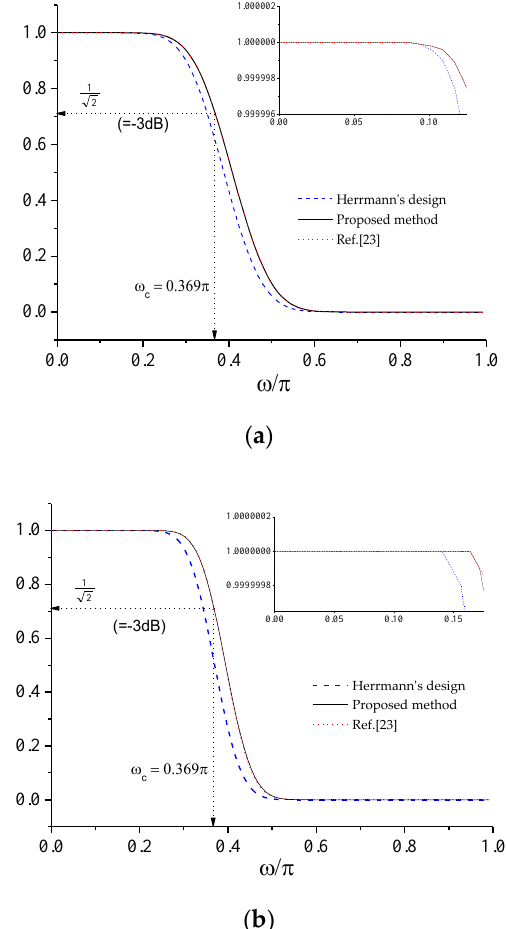
Figure 7. Comparison of three design methods: ( ω c = 0.369 π ) for ( a ) N = 20 and ( b ) N =